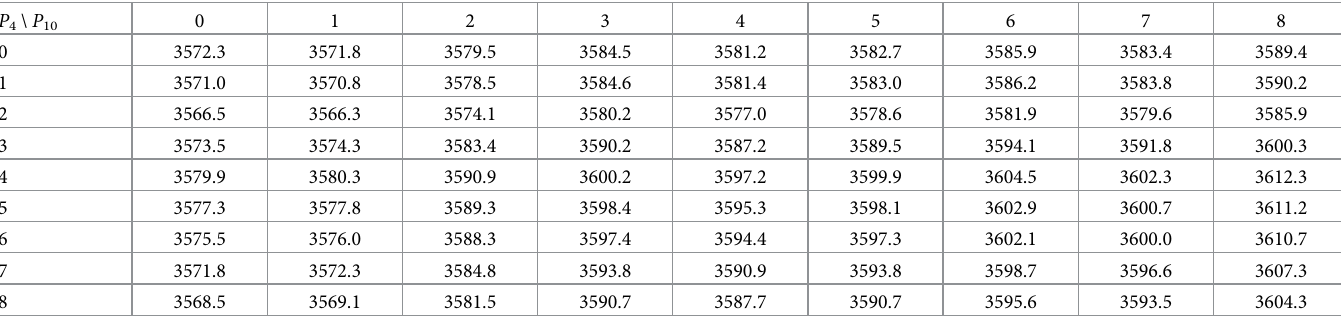
The remaining control points ( P 0 , ... , P 3 , P 5 , ... , P 9 , P 11 , ... , P 14 ) have values (4, 7, 5, 4, 6, 8, 7, 7, 8, 5, 4, 3, 4). Total equivalent source energy is measured in